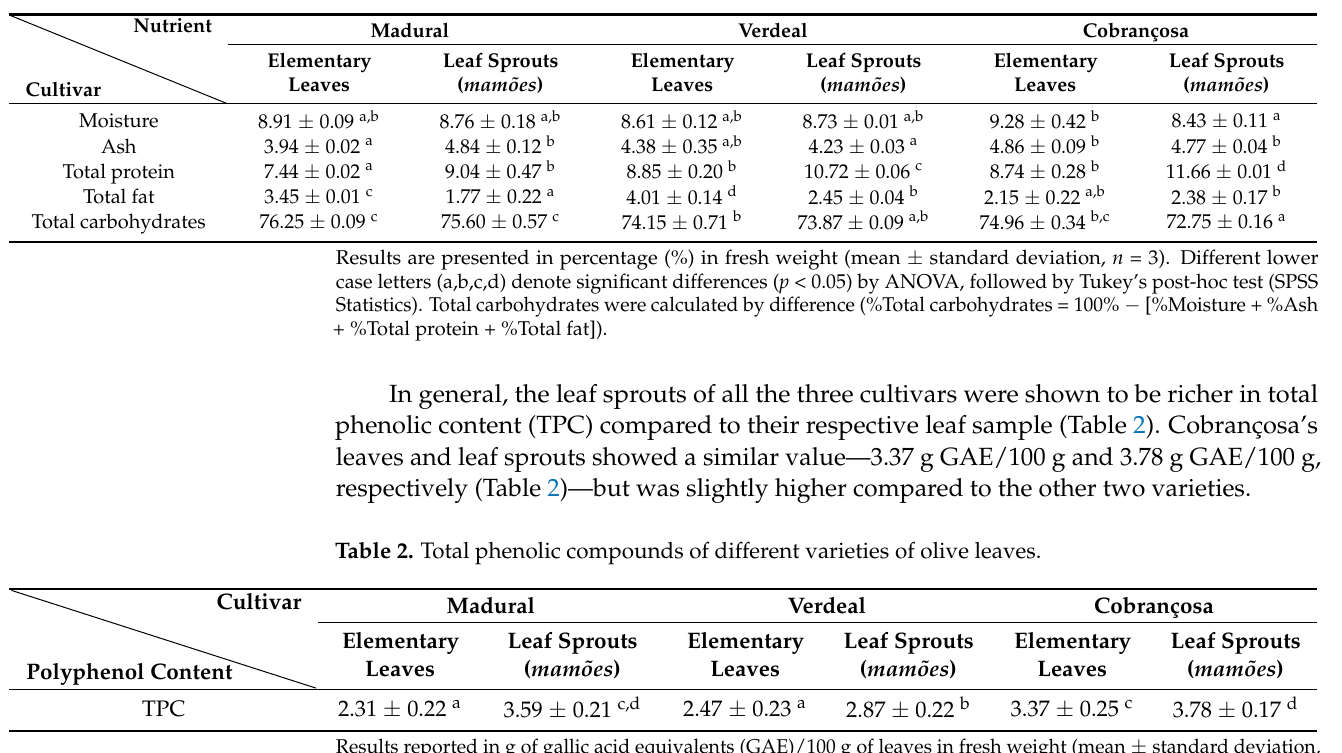
Table 1. Nutritional analysis of different varieties of olive leaves.